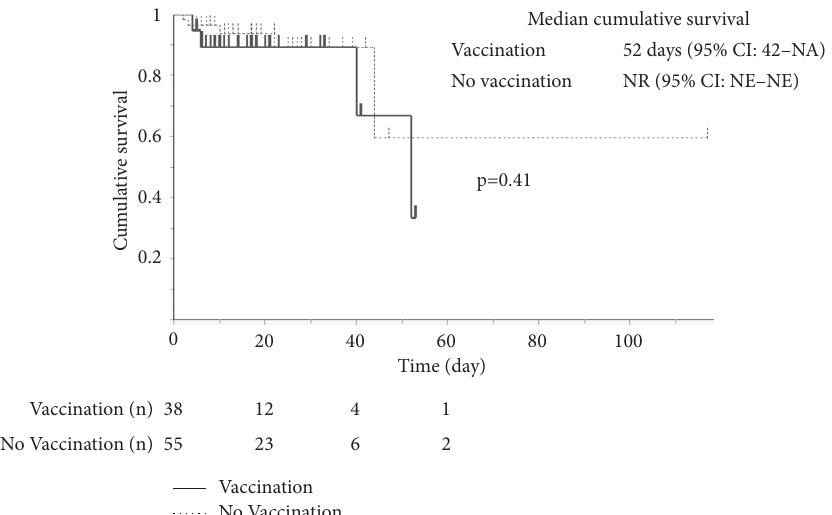
Figure 1: The Kaplan–Meier survival curves for the vaccinated and unvaccinated groups. Six patients in the vaccinated group and five patients in the unvaccinated group did not survive. The survival curves showed no significant difference between the two groups (NA: not available; NR: not reached; NE: not evaluated). Table 5: Distribution of pathogens in pneumococcal vaccinated and unvaccinated patients.